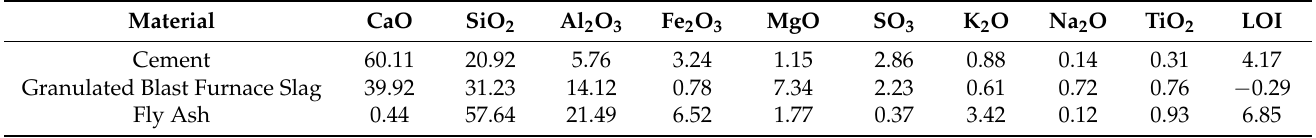
Table 1. Chemical composition of cement, granulated blast furnace slag, and fly ash (wt%).